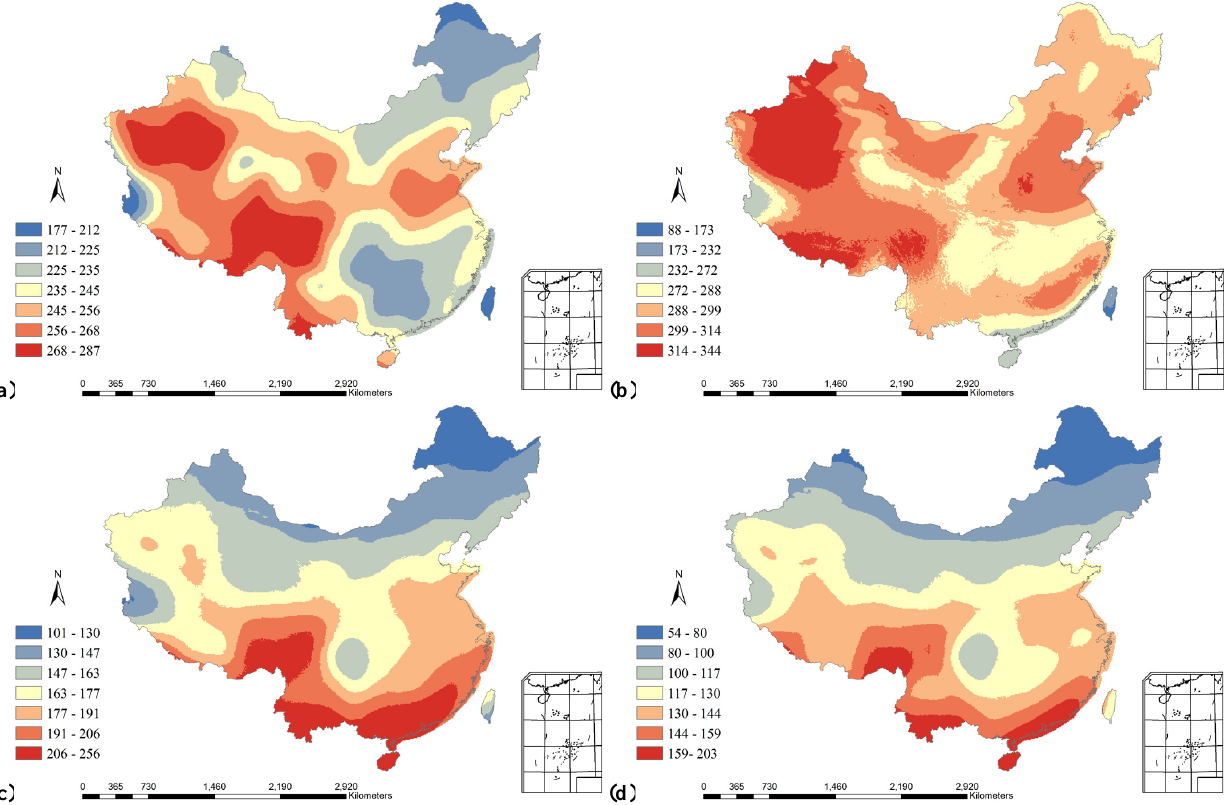
Fig. 3. Spatial distribution of perennial average of seasonal diffuse radiation in China during 1981–2010 ( a , b , c and d denote spring, summer, autumn and winter, respectively. Unit: MJm − 2 month − 1 ) . Table 1. Results of the calibration and validation of Angstrom model in different regions across China. Estimated values and validation Northwest Inner Northeast North Central South Southwest Qinghai-Tibet of parameters China Mongolia China China China China China